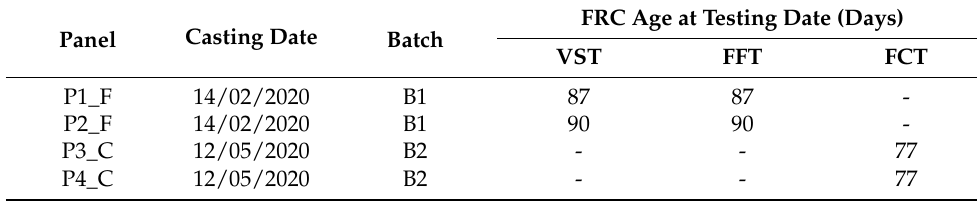
Table 6. Experimental programme.